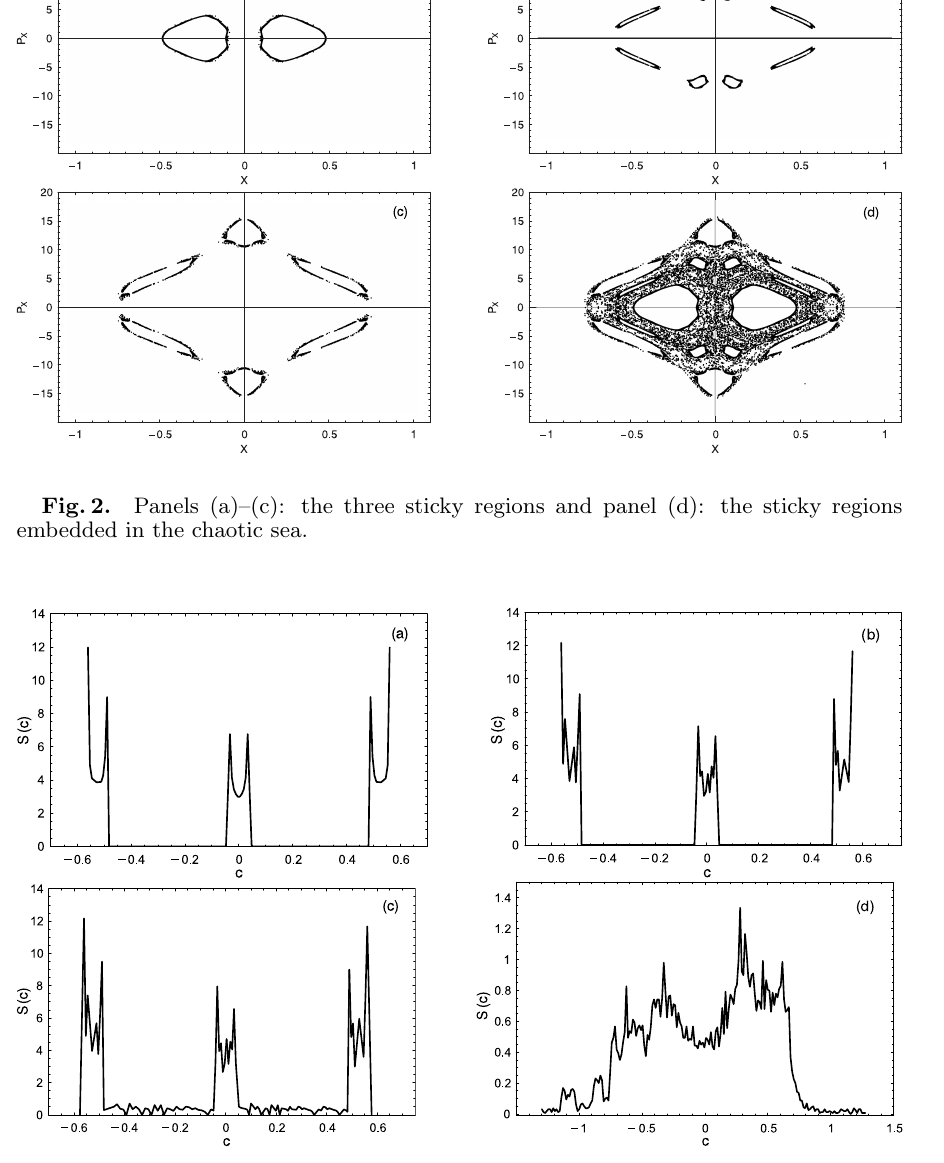
Fig. 3. Panel (a): the S ( c ) spectrum of a nearby quasi-periodic orbit and panels (b)–(d): evolution of the S ( c ) spectrum for a sticky